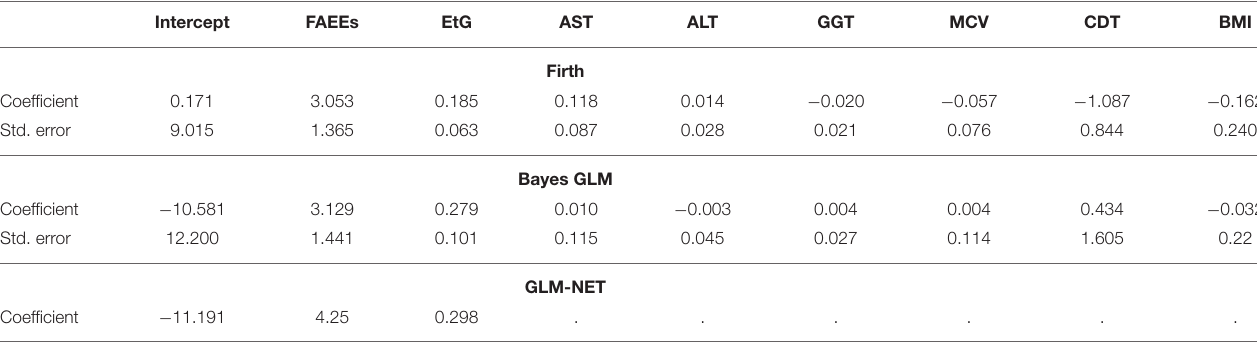
TABLE 4 | Coefficients and standard errors, estimated for the alcohol biomarkers dataset, using penalized/Bayesian logistic regression models: Firth GLM ran using the glm function in the R package brglm2 , Bayes GLM ran using the bayesglm function in the R package arm and GLM-NET ran using the glmnet function in the R package glmnet (standard errors are not provided by default in the glmnet package; however, they can be estimated using bootstrapping; the dots indicate variables that have been dropped from the model).